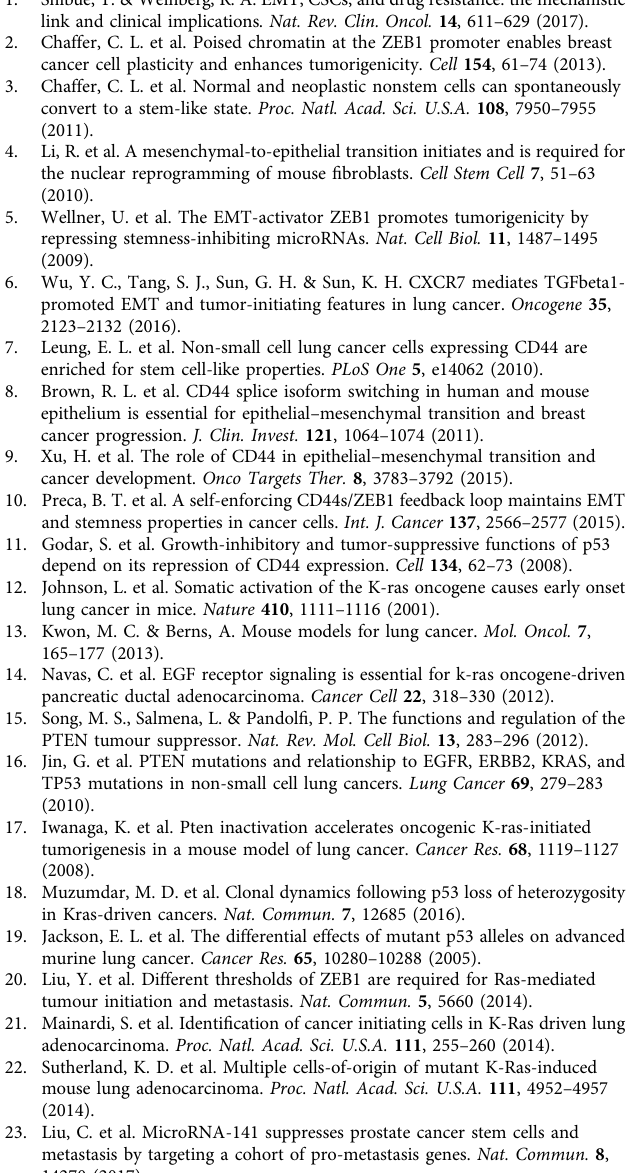
Table 1. Three independent samples, each in triplicate, were analyzed for each real- time PCR condition. The detection of miRNAs was described previously 24 . Brie fl y, polyadenylation of at least 5 µg of total RNA was completed by poly(A) polymerase kit (PAP, Ambion) in 20 µl of reaction volume according to manufacturer ’ s instruction. The polyadenylated RNA was thereafter directly utilized for cDNA preparation using a reverse transcription kit (M-MLV reverse transcriptase, Invi- trogen) and an adaptor primer (5 ′ -GCGAGCACAGAATTAATACGACTCACT ATAGG(T)12VN*-3 ′ ) in 40µl of reaction volume. Real-time quantitative PCR was